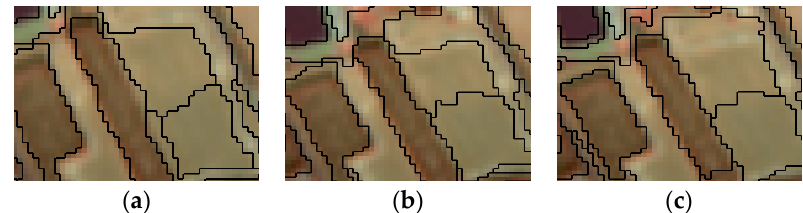
Figure 5. Different weights of compactness and smoothness. ( a ) The weight of smoothness is 0.5, the weight of compactness is 0.5, the segmentation scale is 25. ( b ) The weight of smoothness is 0.3, the weight of compactness is 0.7, the segmentation scale is 25. ( c ) The weight of smoothness is 0.1, the weight of compactness is 0.9, the segmentation scale is 25.